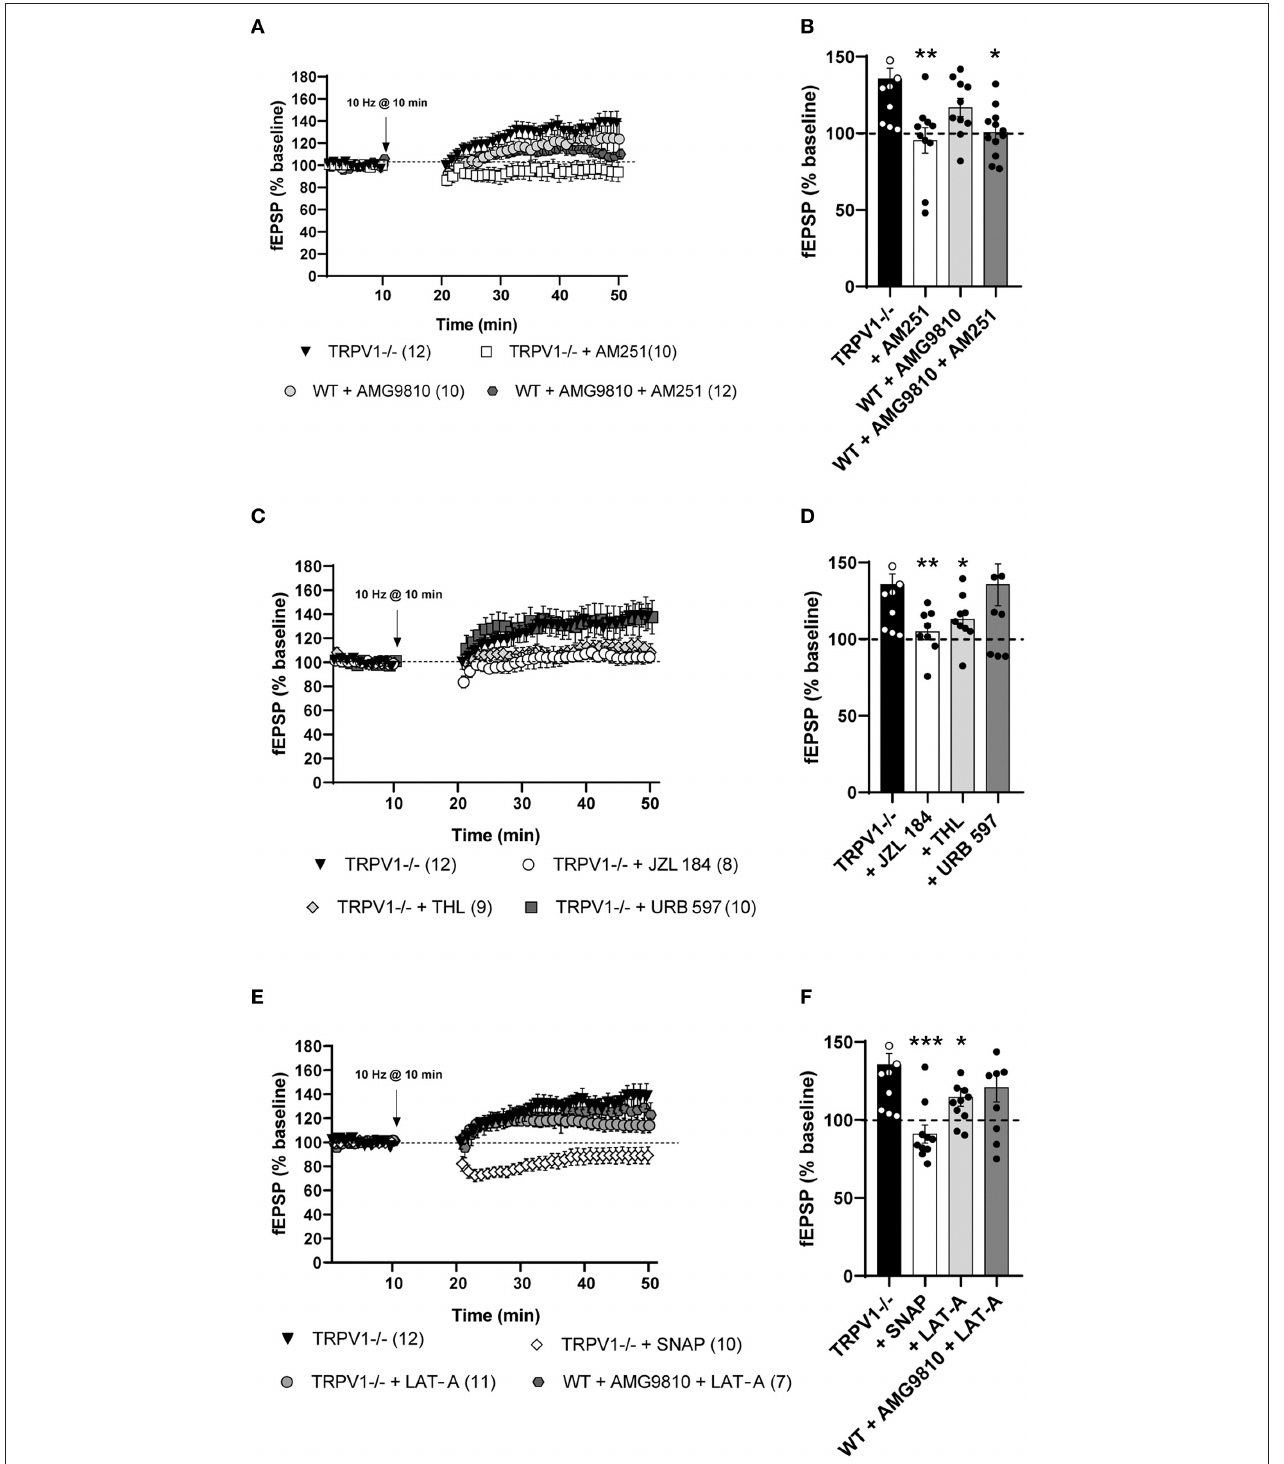
FIGURE 3 | (A) Medial perforant path long-term potentiation (MPP-LTP) in TRPV1-/- is CB 1 receptor-dependent (Mann–Whitney test. p > 0.05 vs. baseline; white squares). The TRPV1 antagonist AMG9810 (3 µ M) triggers MPP-LTP in WT (Mann–Whitney test. * p < 0.05 vs. baseline; light gray circles) that is also CB 1 receptor-dependent (Mann–Whitney test. p > 0.05 vs. baseline; dark gray hexagons). (B) Representative histograms of fEPSP (last 10min) after LFS at MPP in